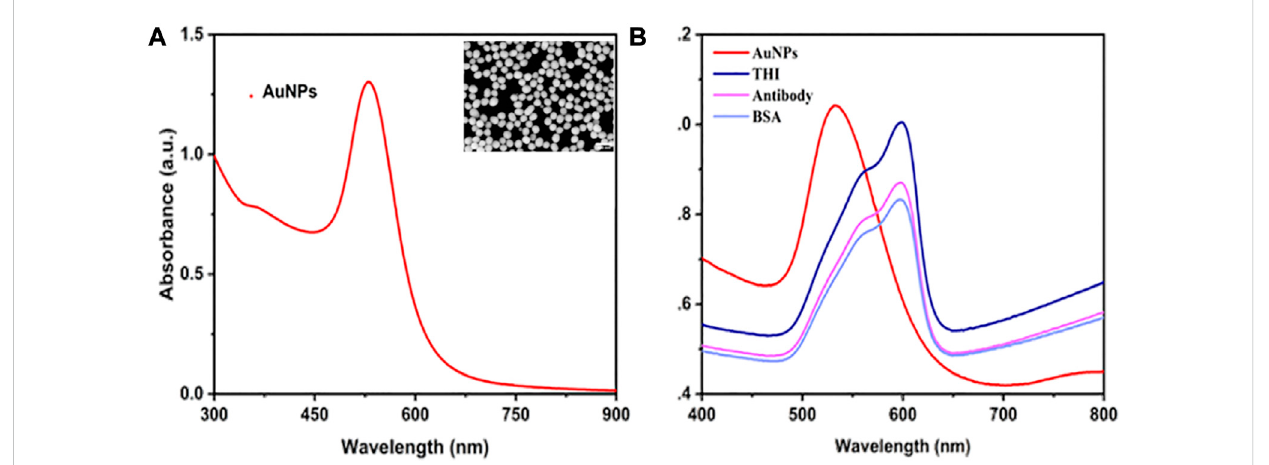
FIGURE 1 Characterization of AuNPs and probes. (A) UV-Vis absorbance spectrum of AuNPs. Inset: SEM image of AuNPs, scale bar = 400 nm. (B) UV-visible spectrum of step-by-step fabrication of the interface, including AuNPs, AuNPs modi fi ed with THI, AuNPs/THI modi fi ed with antibody, and AuNPs/THI/ Antibody modi fi ed with